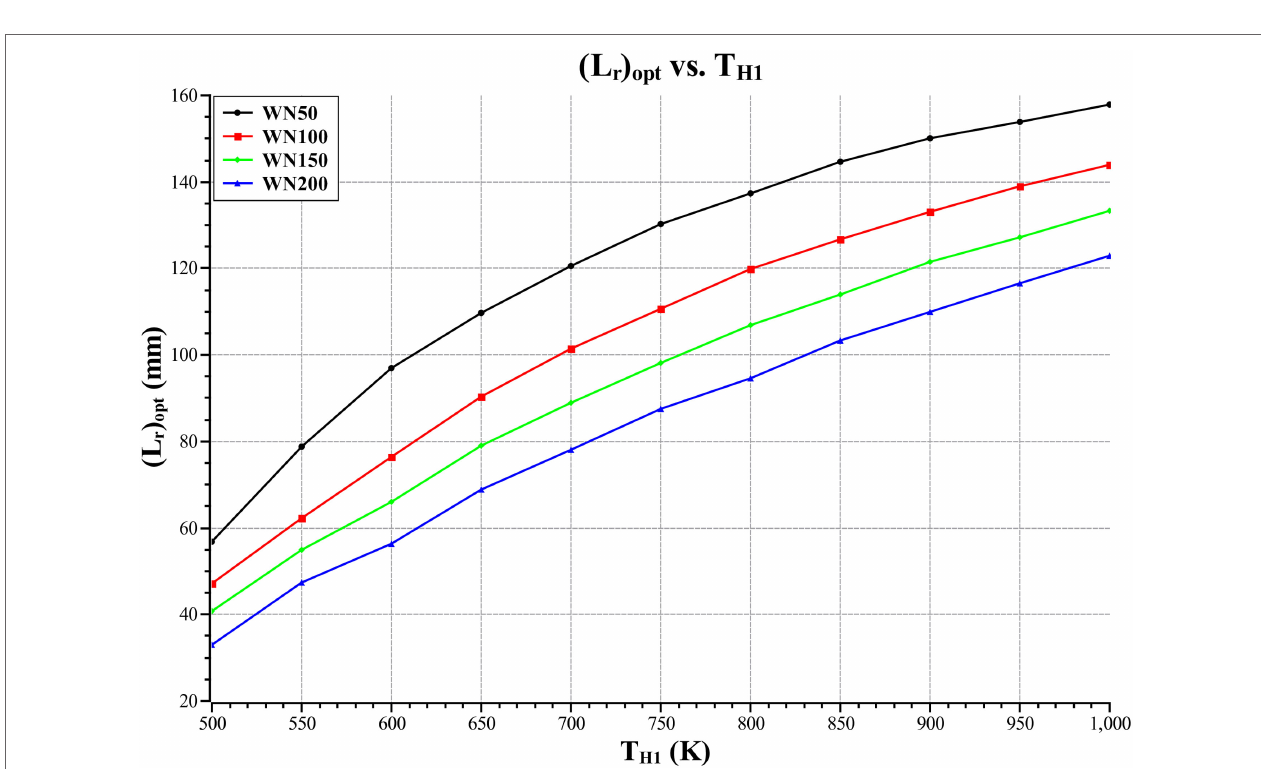
FIGURE 7 | Optimal regenerator length versus heater inlet temperature.